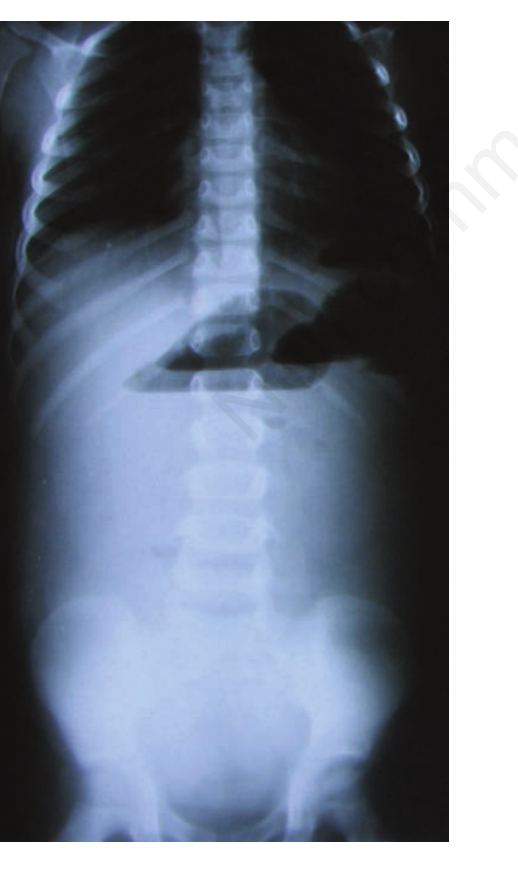
bowel.Figure 1. Supine abdominal plain